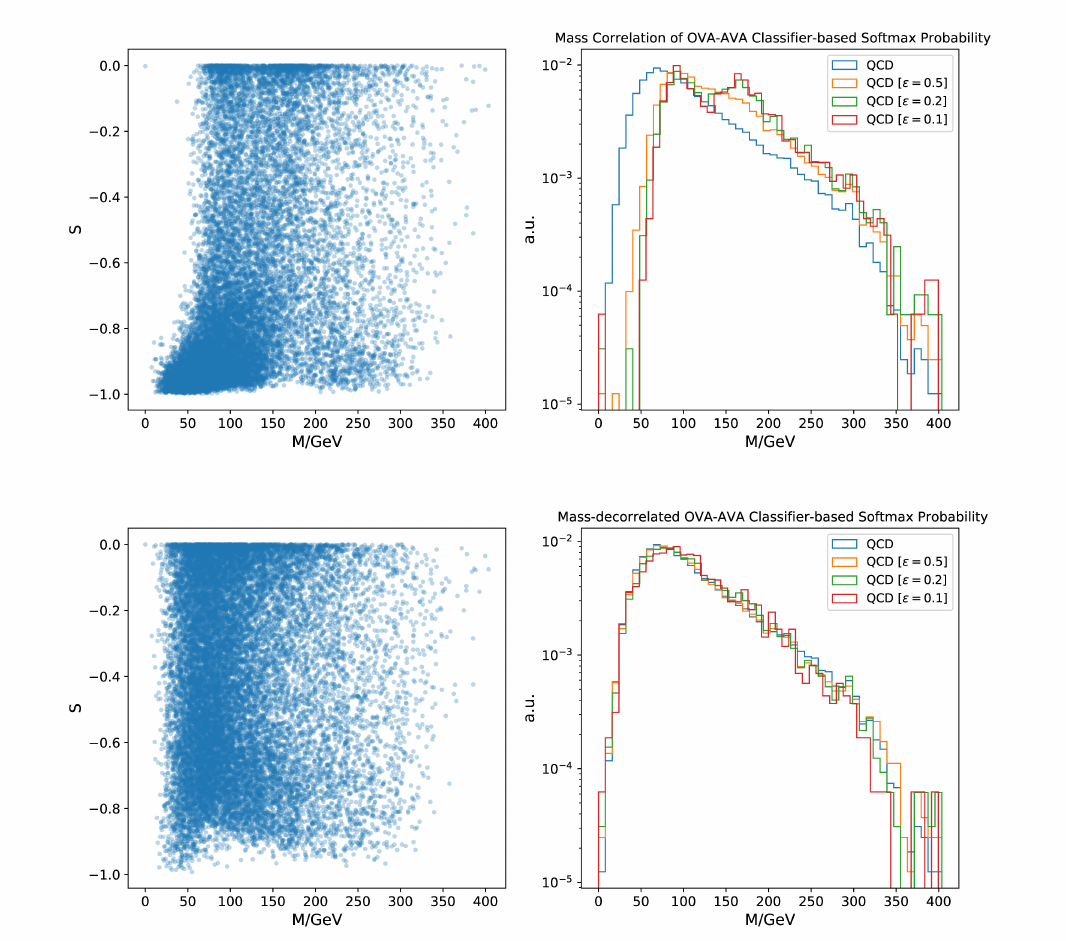
Figure 11 . OVA-AVA Model. Top : The un-decorrelated model with p QCD as the anomaly score. Bottom : The mass-decorrelated model with p QCD as the anomaly score. Left : The correlation between jet mass M and the anomaly score. Right : Mass distributions for different background acceptance rates ( (cid:15)